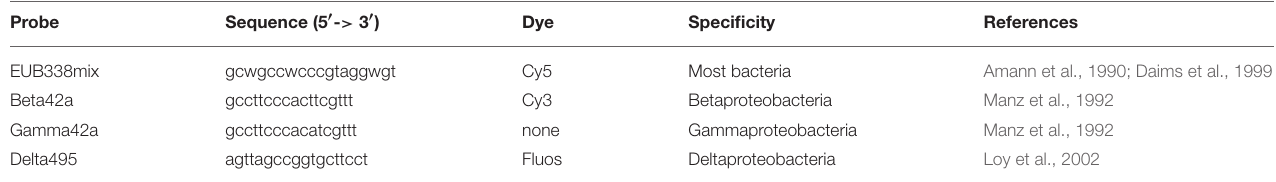
TABLE 2 | Probes used in FISH analysis of the culture.